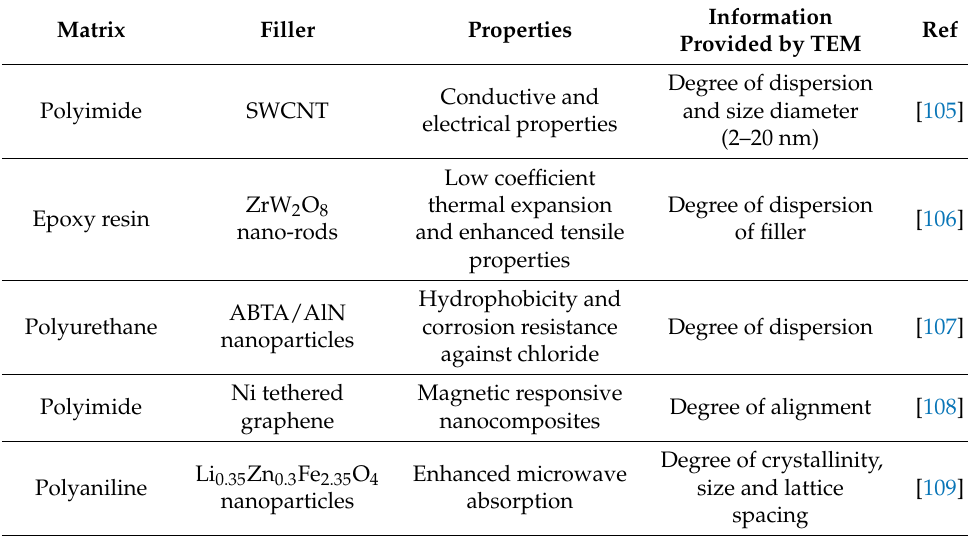
Table 3. Information provided by TEM for polymer nanocomposites.